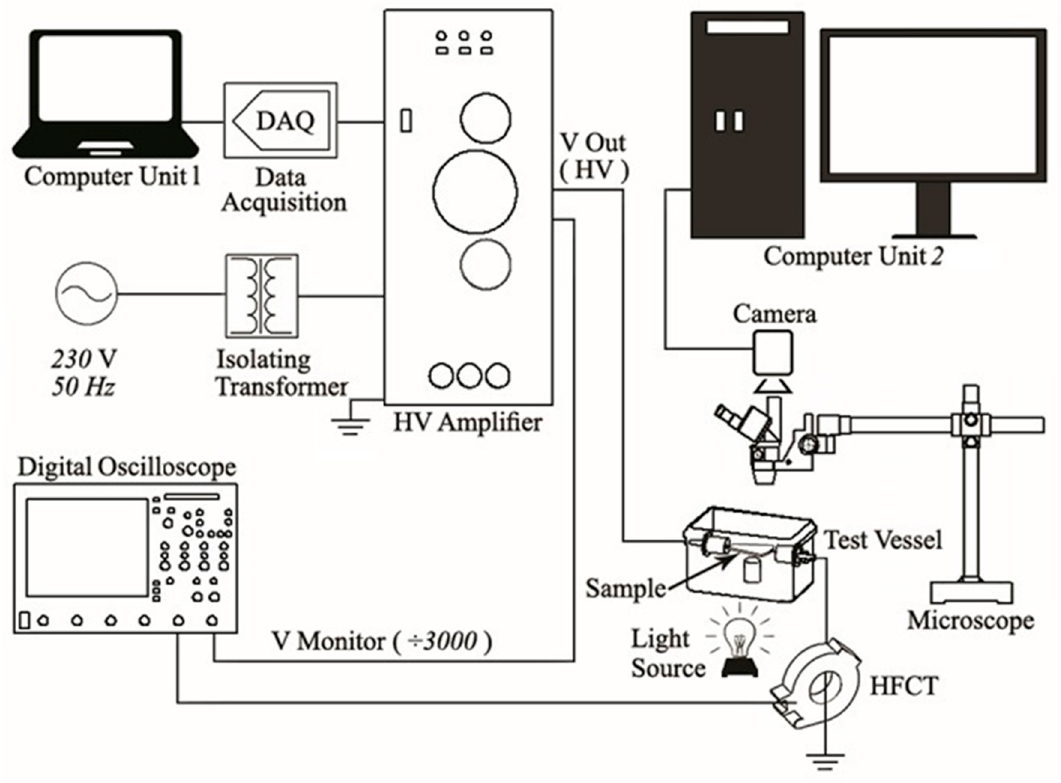
Figure 3. Experimental setup for electrical treeing (ET) optical observation and partial discharge (PD) measurement.